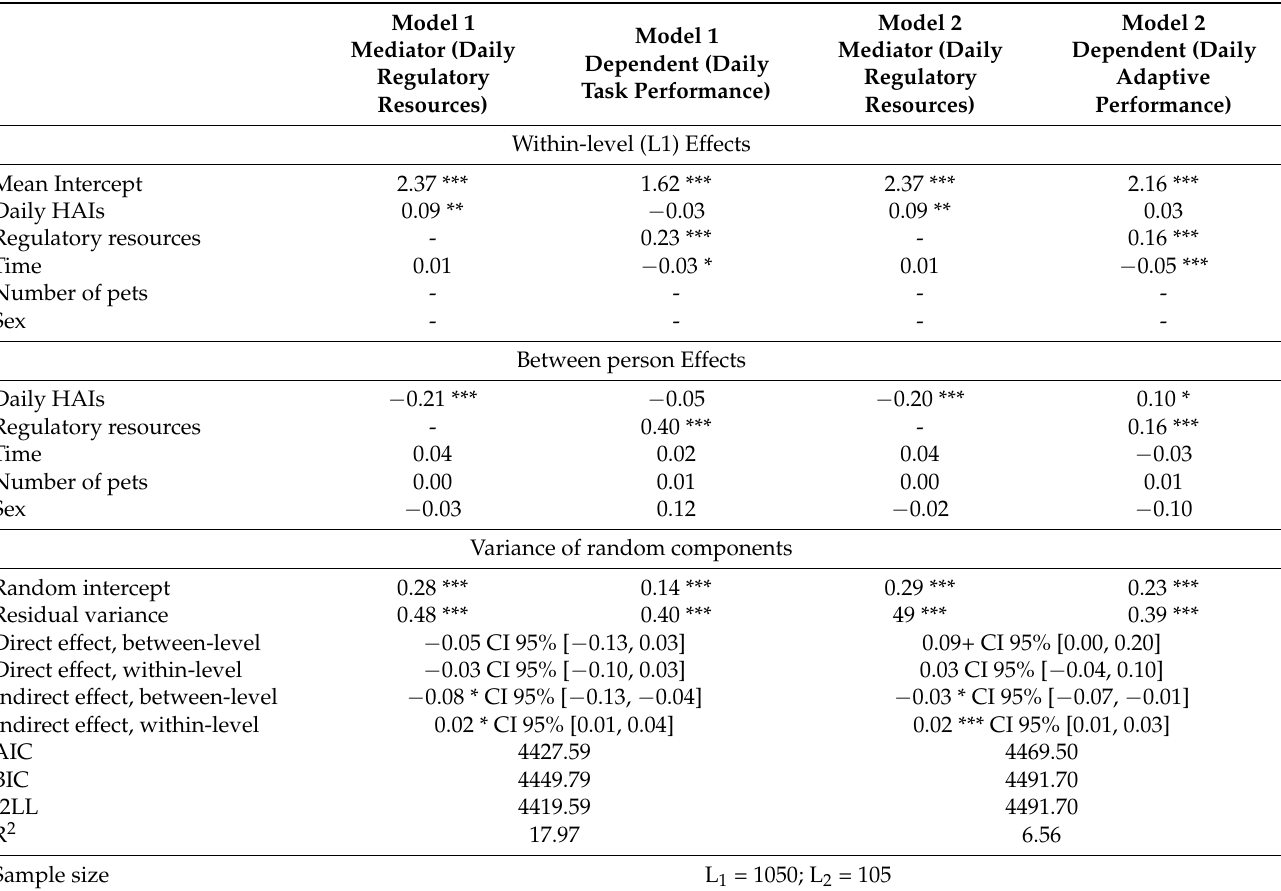
Table 2. Parameter estimates for 1-1-1 multilevel mediation